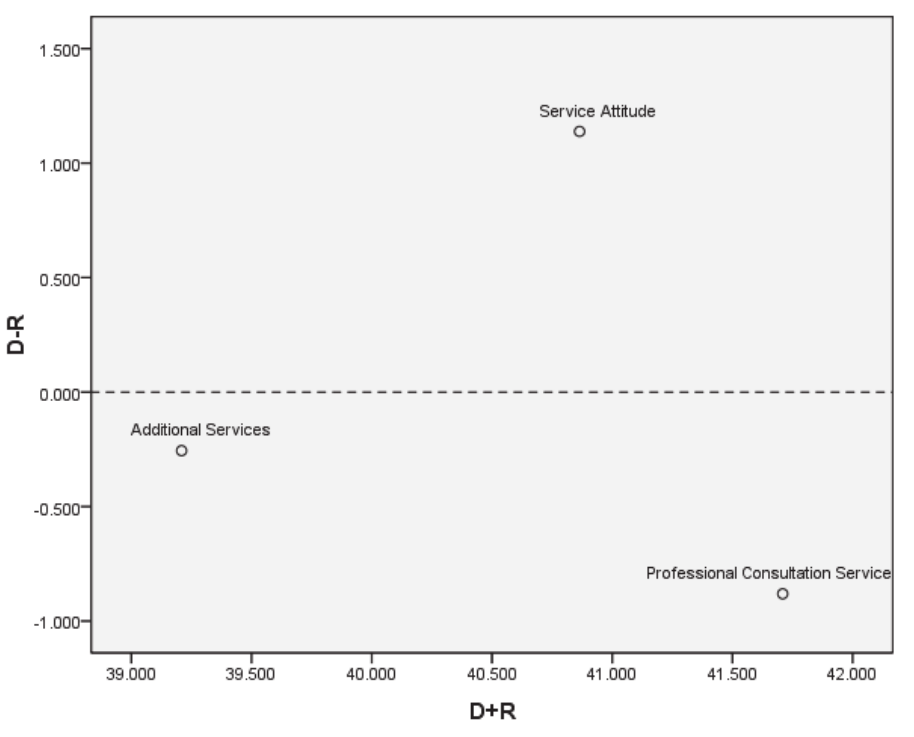
Figure 4. Causal diagram of sub ‐ aspects of wealth management bank image perspective .